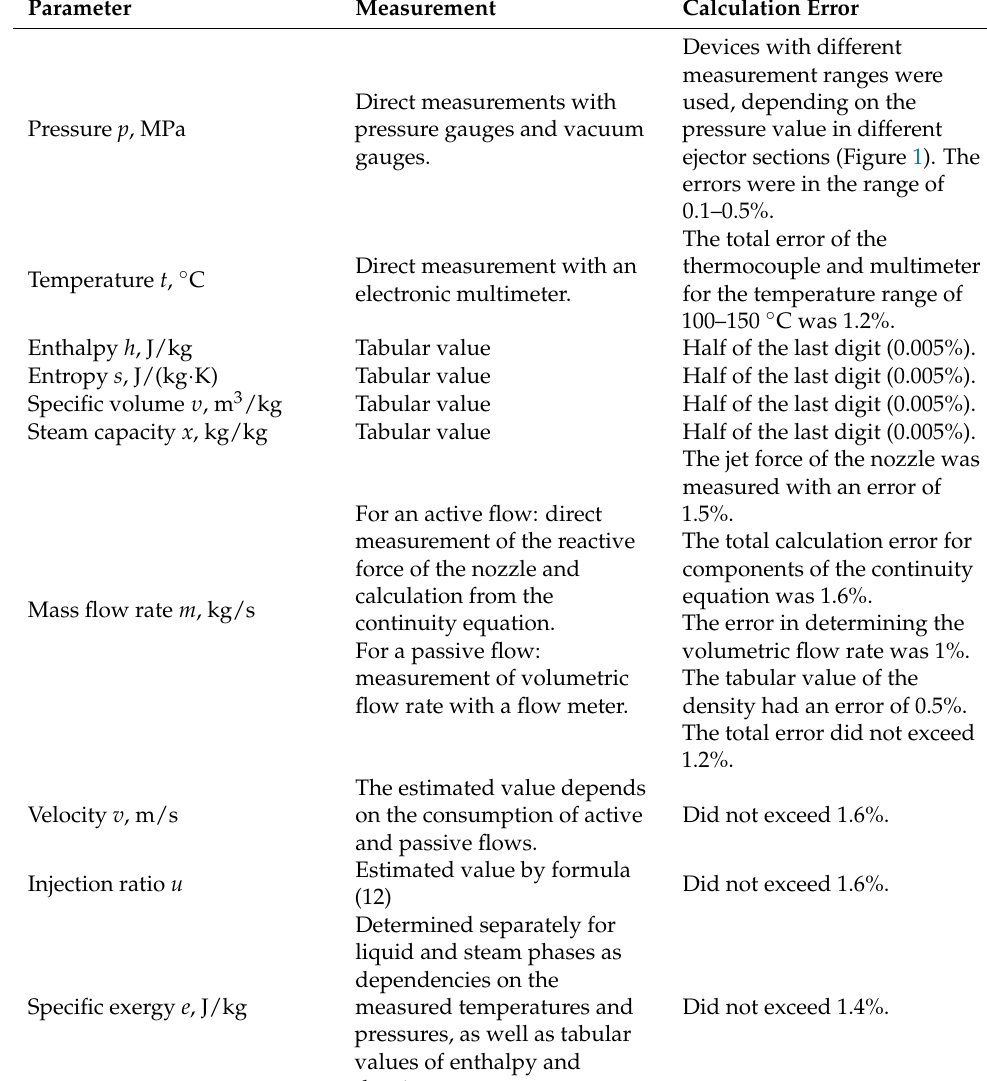
Table 1. Characteristics of the evaluated